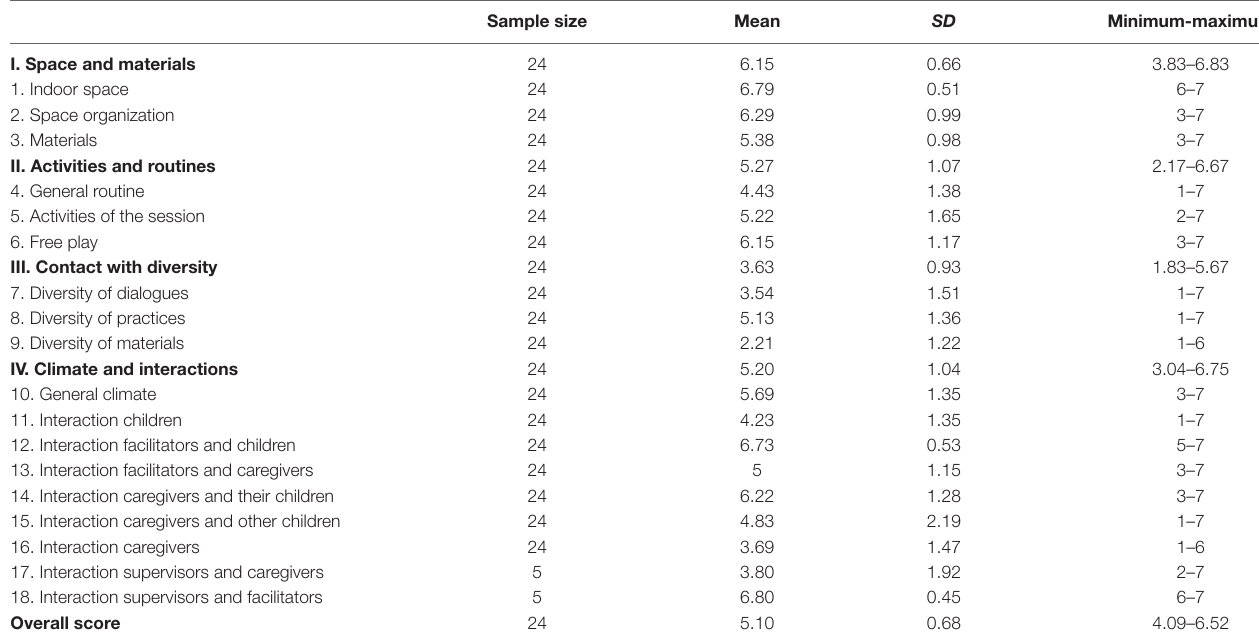
TABLE 6 | Descriptive statistics for the PERS items, subscales, and overall